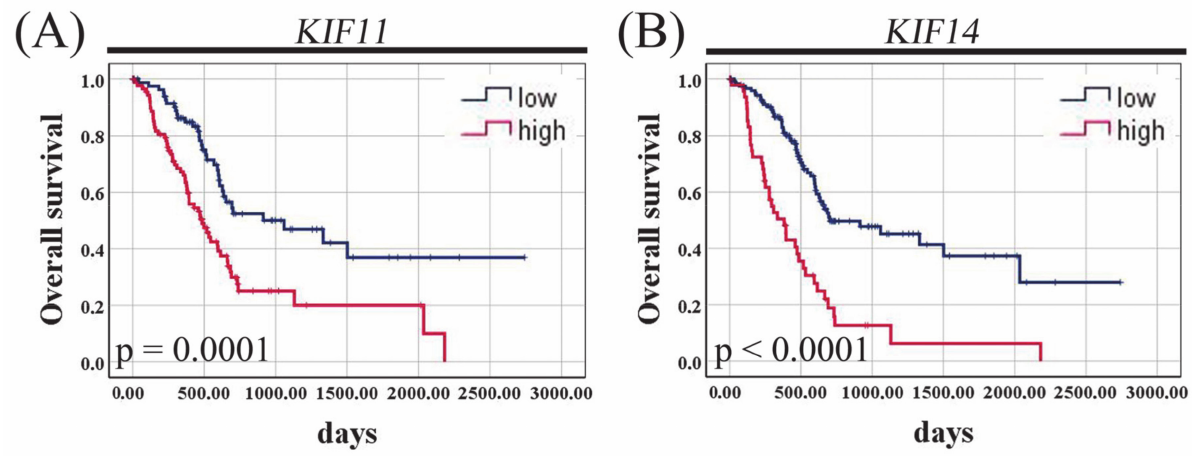
Figure 9. Figure 9. Kaplan–Meier curves for overall survival of pancreatic adenocarcinoma patients of the TCGA cohort stratified by KIF11 ( A ) or KIF14 ( B ) mRNA expression. p -Values were calculated using the log-rank test.